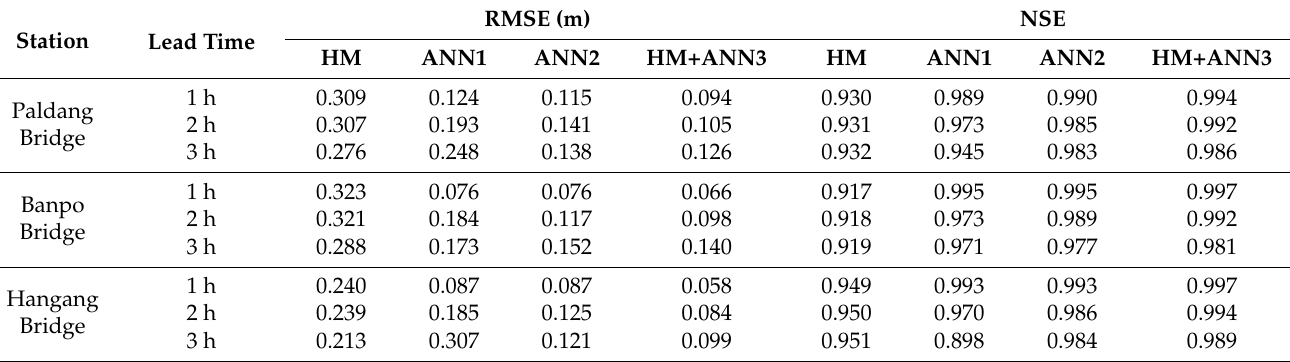
Table 7. Statistical comparison of model performances for the validation